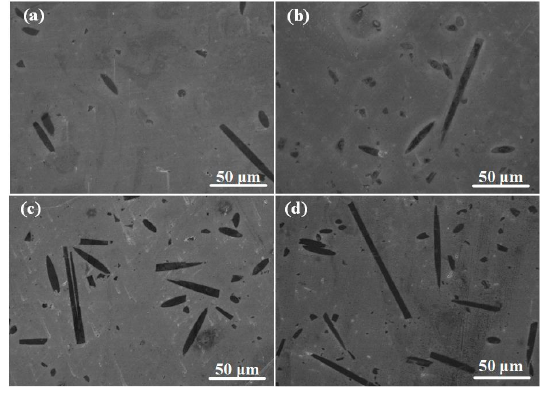
Figure 1. SEM images for the 2024 Al matrix composites with ( a ) 2, ( b ) 4, ( c ) 6 and ( d ) 8 vol. % short carbon fibers (SCFs).